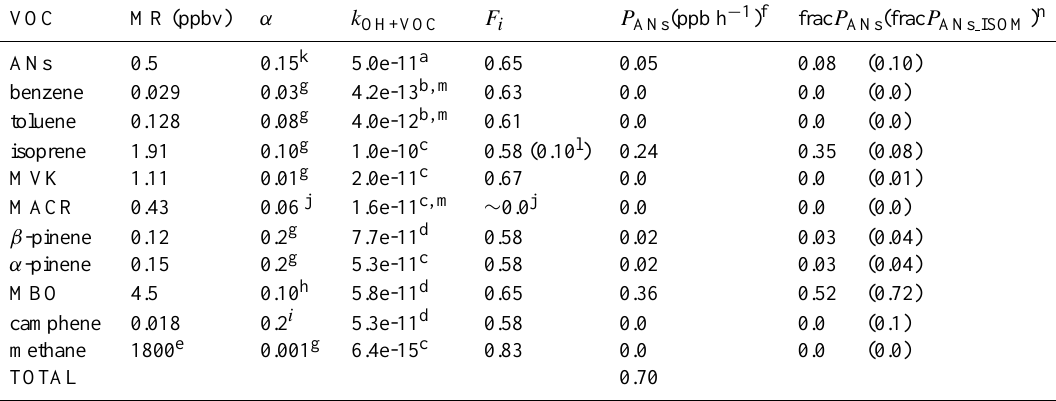
Table 1. Locally observed and estimated alkyl nitrate VOC precursors for BEARPEX 2009. Mixing ratios (MR) are mean afternoon (12:00– 18:00 PST) concentrations. Nitrate yields and rate constants are from the literature as cited. a (Paulot et al., 2009a); b (Atkinson and Arey, 2003a); c (Atkinson et al., 2006); d (Atkinson and Arey, 2003a); e estimated; f OH=6 × 10 6 moleculescm − 3 (Bouvier-Brown et al., 2009;